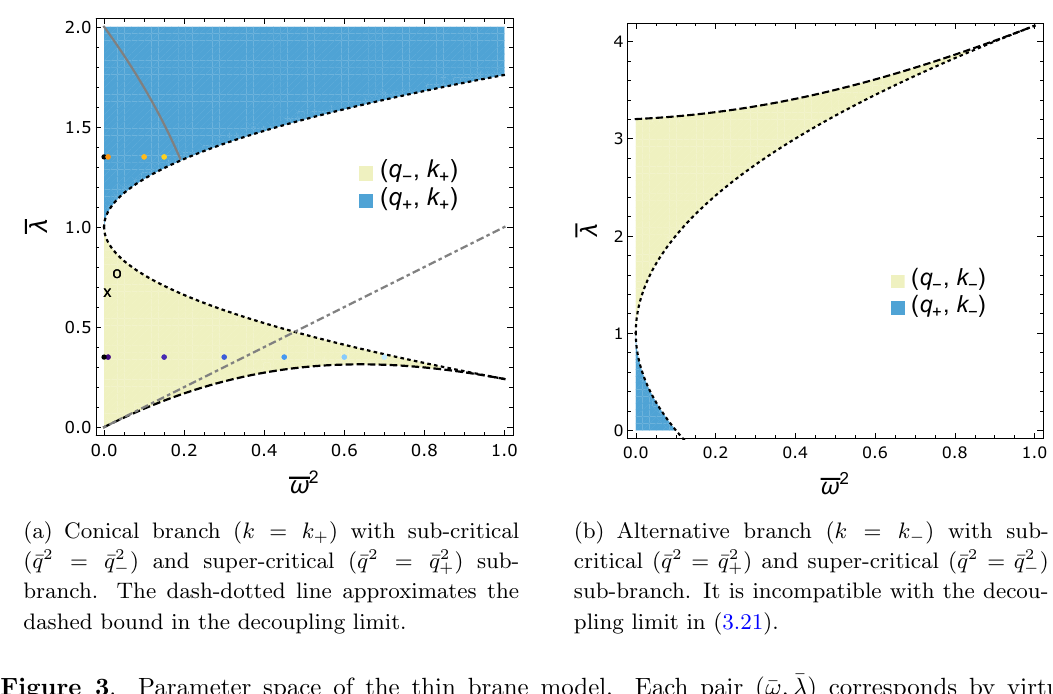
Figure 3 . Parameter space of the thin brane model. Each pair ((cid:22) !; (cid:22) (cid:21) ) corresponds by virtue of (3.20) to a particular value of (cid:22) q 2 (and to a certain value of R 0 once the winding number has been (cid:12)xed). The dotted and dashed lines depict the positivity bound on A 2 and (cid:22) q 2 , respectively. Only the shaded regions admit a stable